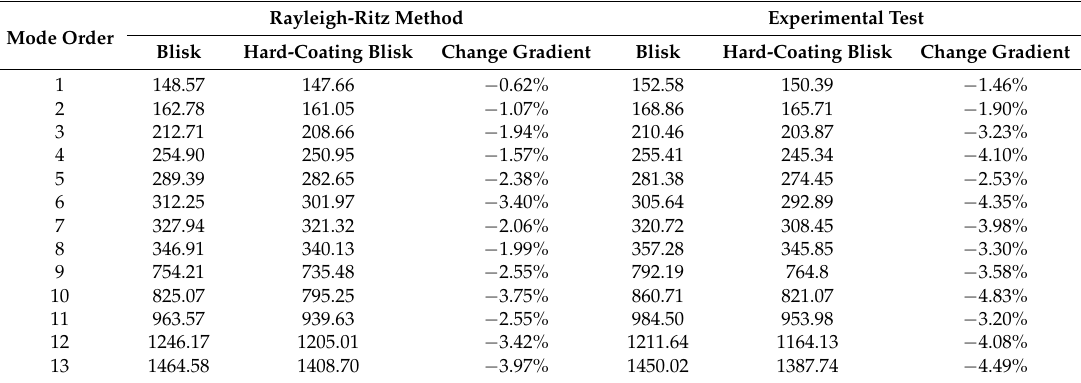
Table 4. Natural frequencies of the blisk with or without hard coating (Hz).